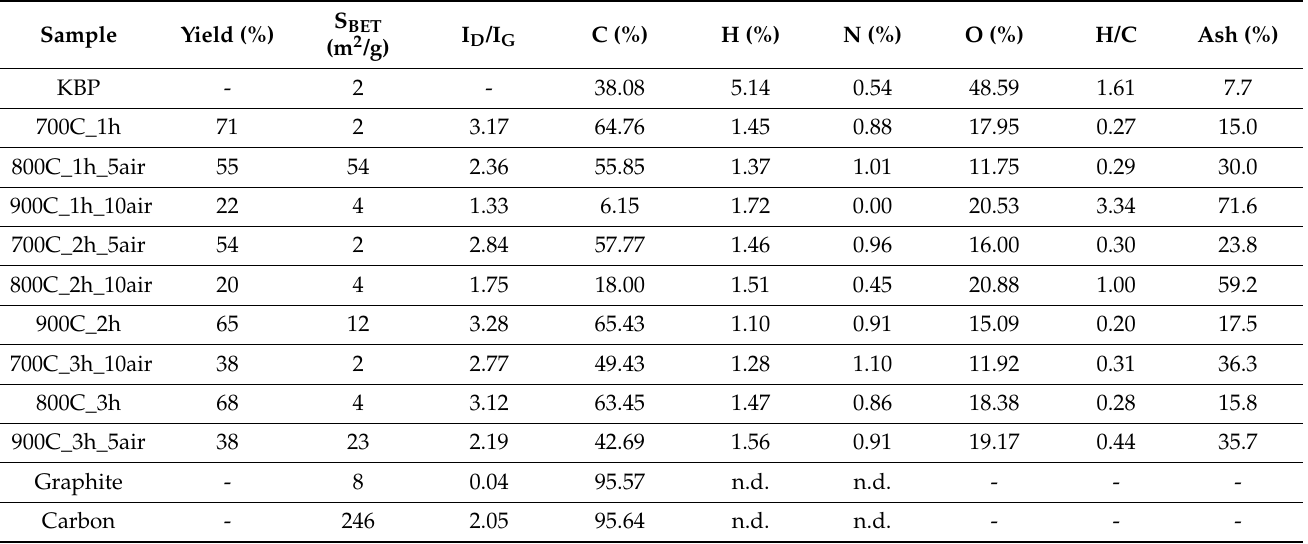
Table 1. Yield (%), S BET (m 2 /g), I D /I G ratio, and content (%) of C, H, N, O, and ash of the biochars, commercial graphite, and